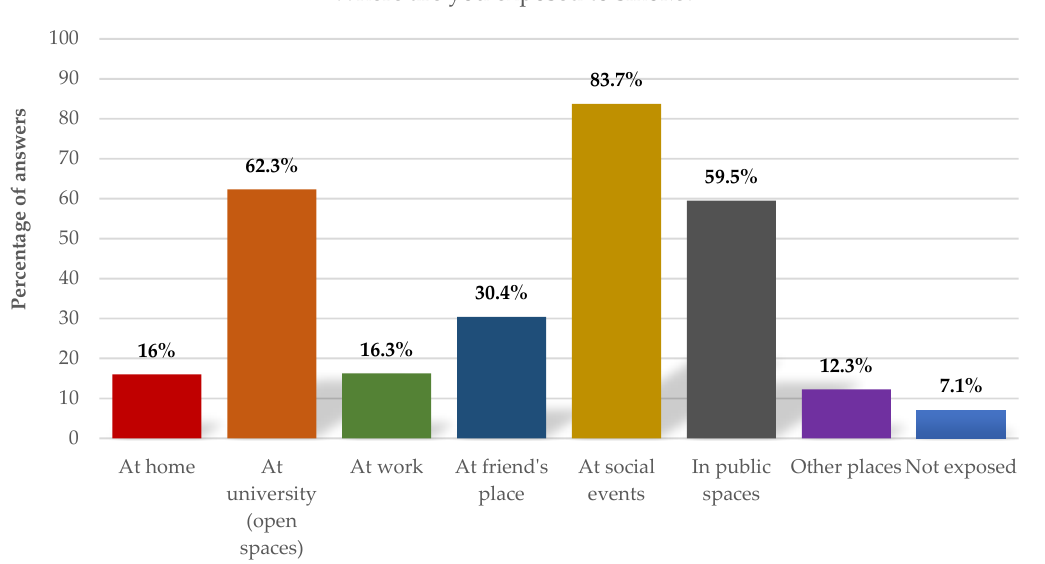
Figure 2. Places of exposure to tobacco smoke.